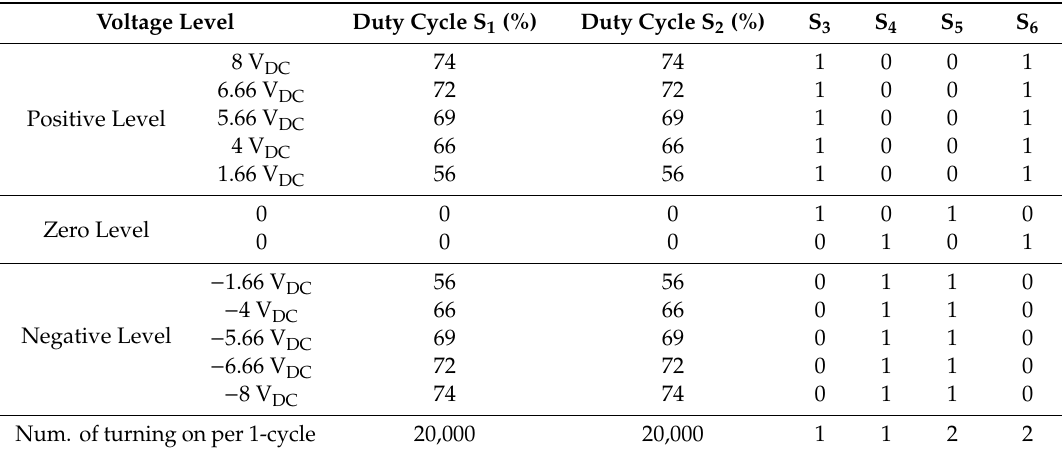
Figure 1. The proposed single source multilevel inverter. Table 1. Switching table level = 11, gain = 8.